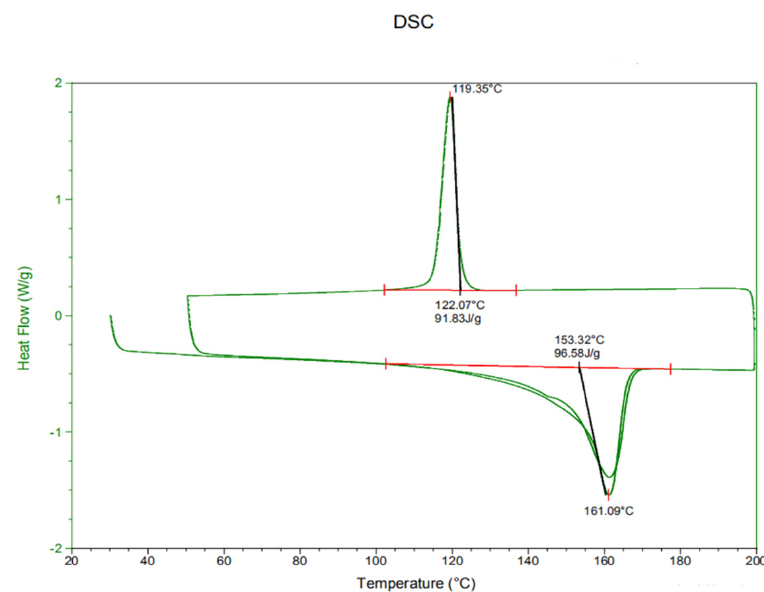
Figure 2. DSC result of Polypropylene via heat-cool-heat cycle.